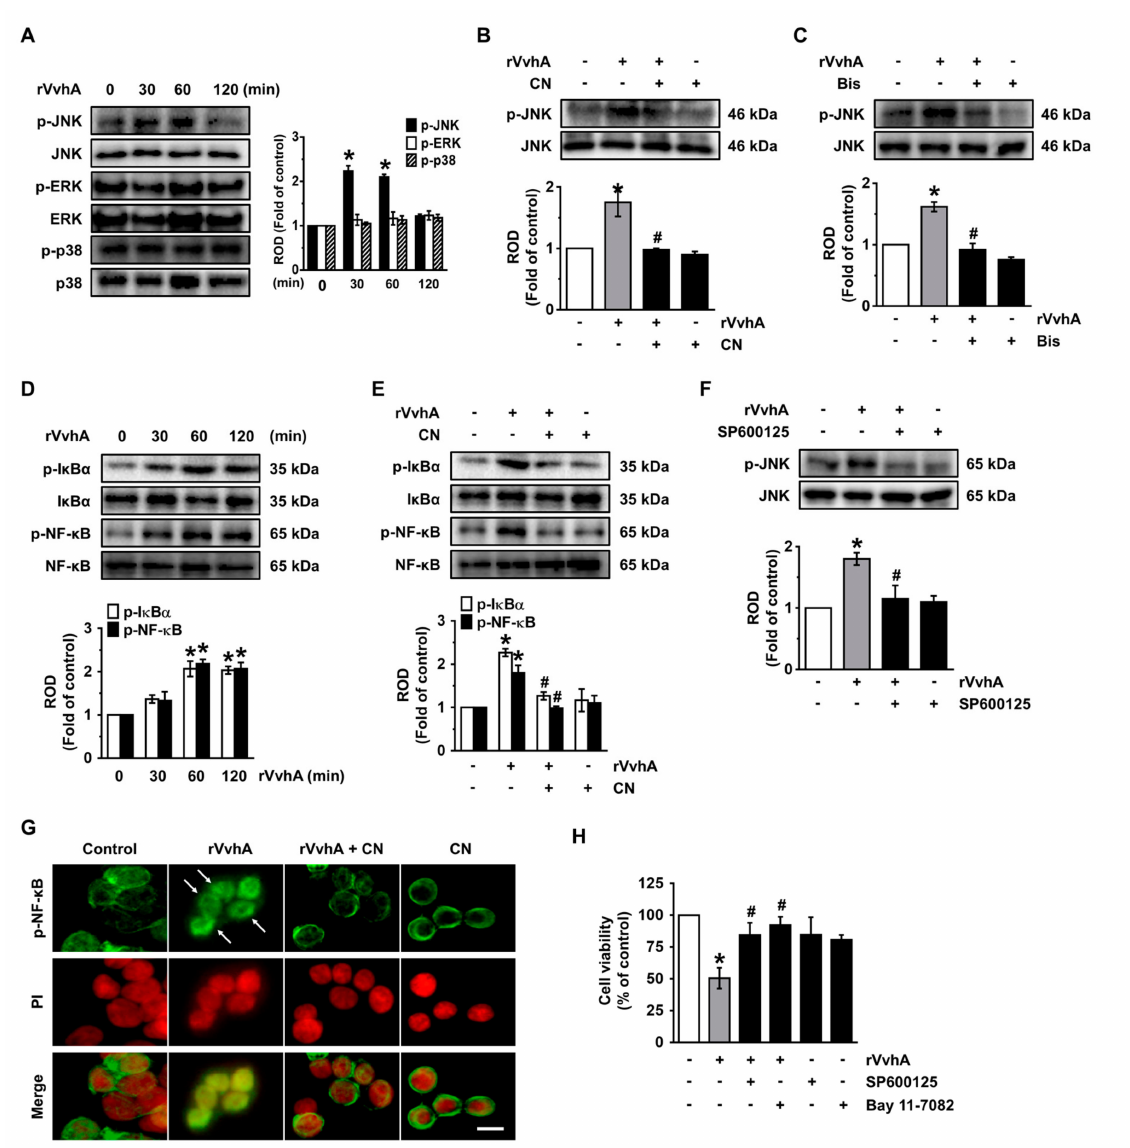
Figure 4. CN uniquely regulates the c-Jun n-terminal kinase (JNK) / nuclear factor-kappa B (NF- κ B) pathway responsible for cell death caused by rVvhA. ( A ) Time responses of phosphorylation of mitogen-activated protein kinases (MAPK) in cells exposed to rVvhA are shown. n = 3. * p ≤ 0.001 vs. control. ( B ) The e ff ect of CN on the phosphorylation of JNK is shown. n = 3. * p ≤ 0.01 vs. control. # p ≤ 0.01 vs. rVvhA alone. ( C ) Cells were pretreated with Bisindolylmaleimide I prior exposure to rVvhA for 30 min. ( D ) Cells pretreated with SP600125 (10 µ M) were incubated with rVvhA for 24 h. n = 3. * p ≤ 0.001 vs. control. # p ≤ 0.01 vs. rVvhA alone. ( E ) Time responses of phosphorylation of I κ B α and NF- κ B in cells exposed to rVvhA are shown. n = 3. * p ≤ 0.001 vs. control. ( F ) The e ff ect of CN on the phosphorylation of I κ B α and NF- κ B is shown. n = 3. * p ≤ 0.01 vs. control. # p ≤ 0.01 vs. rVvhA alone. ( G ) Cells were treated with CN and rVvhA to confirm the nuclear translocalization of NF- κ B determined by immunofluorescence staining. Scale bars, 100 µ m (Original magnification × 400). n = 3. ( H ) Cells were pretreated with SP600125 and Bay 11-7082 (10 µ M) prior exposure to rVvhA for 30 min. n = 3. * p ≤ 0.001 vs. control. # p ≤ 0.01 vs. rVvhA alone. Data represent the mean ± S.E. ( A – F ) ROD is the abbreviation for relative optical